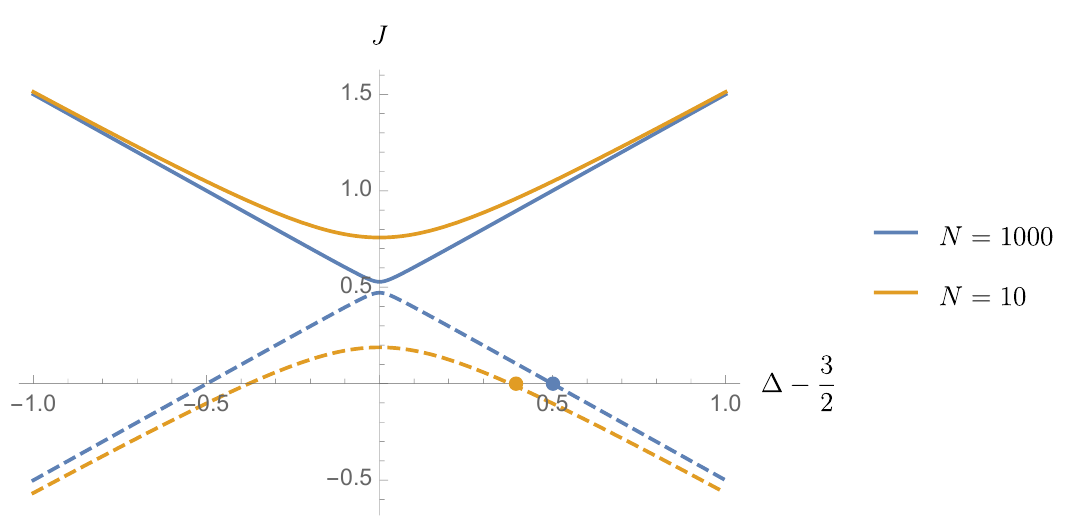
Figure 22 . The Chew-Frautschi plot for [ φφ ] S and its analytic continuation (dashed lines) of the [ φφ ] 0 ,S is plotted for N = 1000 and N = 10 . We see that as N increase the intercept approaches 1 / 2 from above. Note that the curves plotted here are valid up to order 1 /N . Dots indicate the spin-0 S